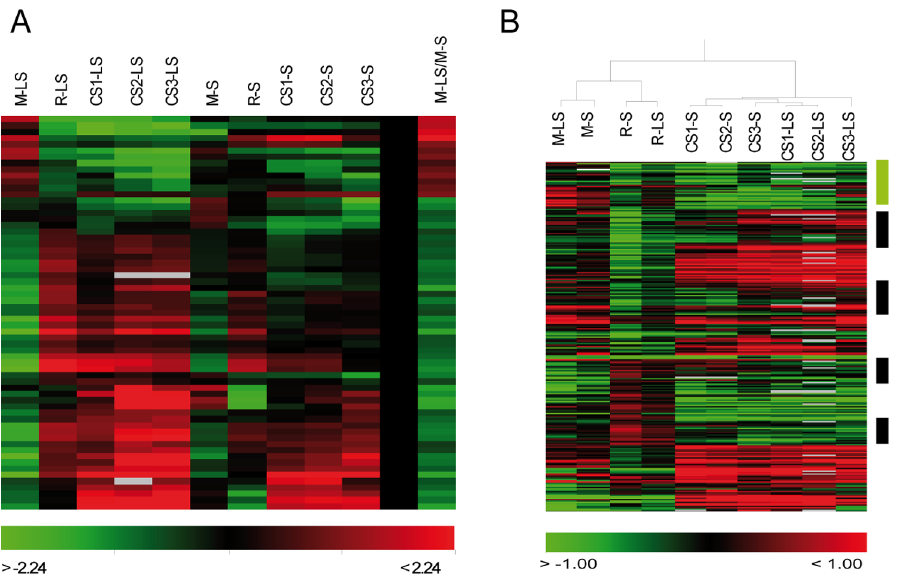
Figure 3. Preformed mechanisms and effect of ripening. A) The hierarchical cluster of the 63 genes differentially expressed between fruits LS and S at the mature stage. The expression values for samples M, R and CS and the M-LS vs. M-S ratio are shown. B) Hierarchical clustering of the expression values for 862 ripening genes (up or down in fruits R respect to M) during cold storage. M=mature fruits, R=mature with 2–4 days ripening at 20 u C, CS1=M + 1 week cold storage at 5 u C, CS2=M + 2 weeks cold storage at 5 u C, CS3=M + 3 weeks cold storage at 5 u